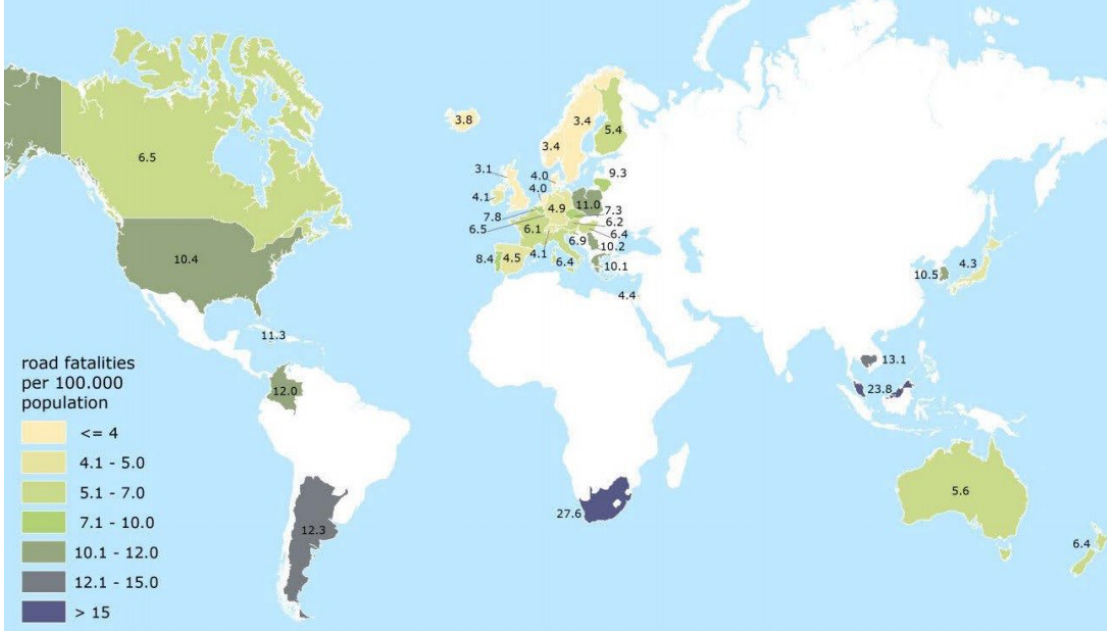
Figure 1. Road fatalities per 100,000 population in 2011 (International Road Traffic and Accident Database (IRTAD) annual road safety report 2013)